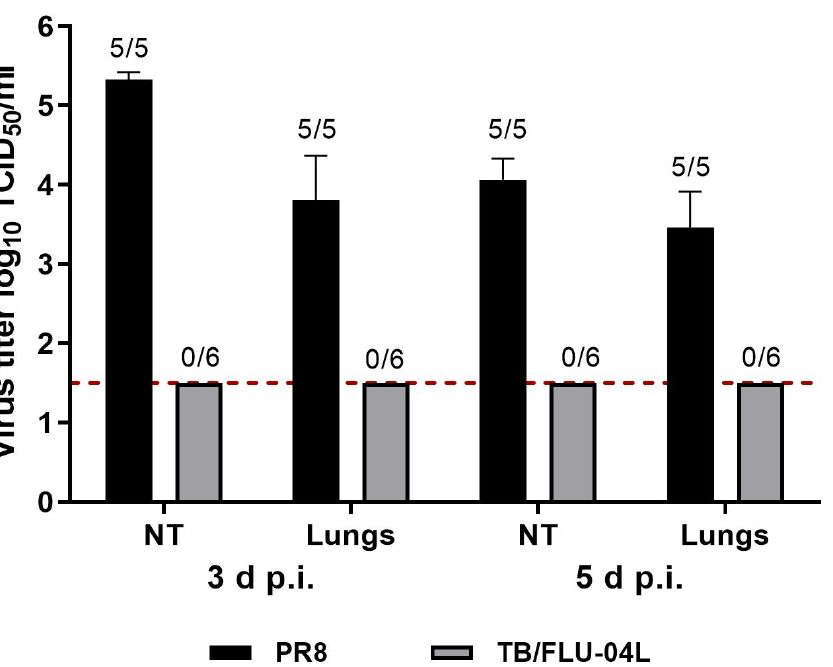
Figure 2. Virus shedding. Groups of ten or twelve 7–8 weeks old female C57bl/6 mice were inoculated with 0.01 mL of either TB/FLU-04L in a dose 6.0 log 10 TCID 50 /animal or A/PR/8/34 in a dose 5.0 log 10 TCID 50 /animal under slight ether anesthesia. Viral loads in 10% suspensions of nasal turbines and lungs were determined on days 3 and 5 post-inoculation in Vero cells. The virus titers are expressed as the mean log 10 TCID 50 /mL ± SEM from 5–6 animals. The limit of virus detection was 1.5 log 10 TCID 50 /mL (red dotted line). Tissues, where no virus was detected, were assigned the value of 1.5 log 10 TCID 50 /mL for the calculation of the mean titer. The numbers placed above the bars reflect the ratio of animals with virus shedding to the total number of animals in the group. Mice with a lung virus load <1.5 log 10 TCID 50 /mL were classified as not infected. The percentages of CD4 + and CD8 + effector memory T-lymphocytes (T em ), which produced any combination of IFN γ , IL2, and TNF α in response to in vitro